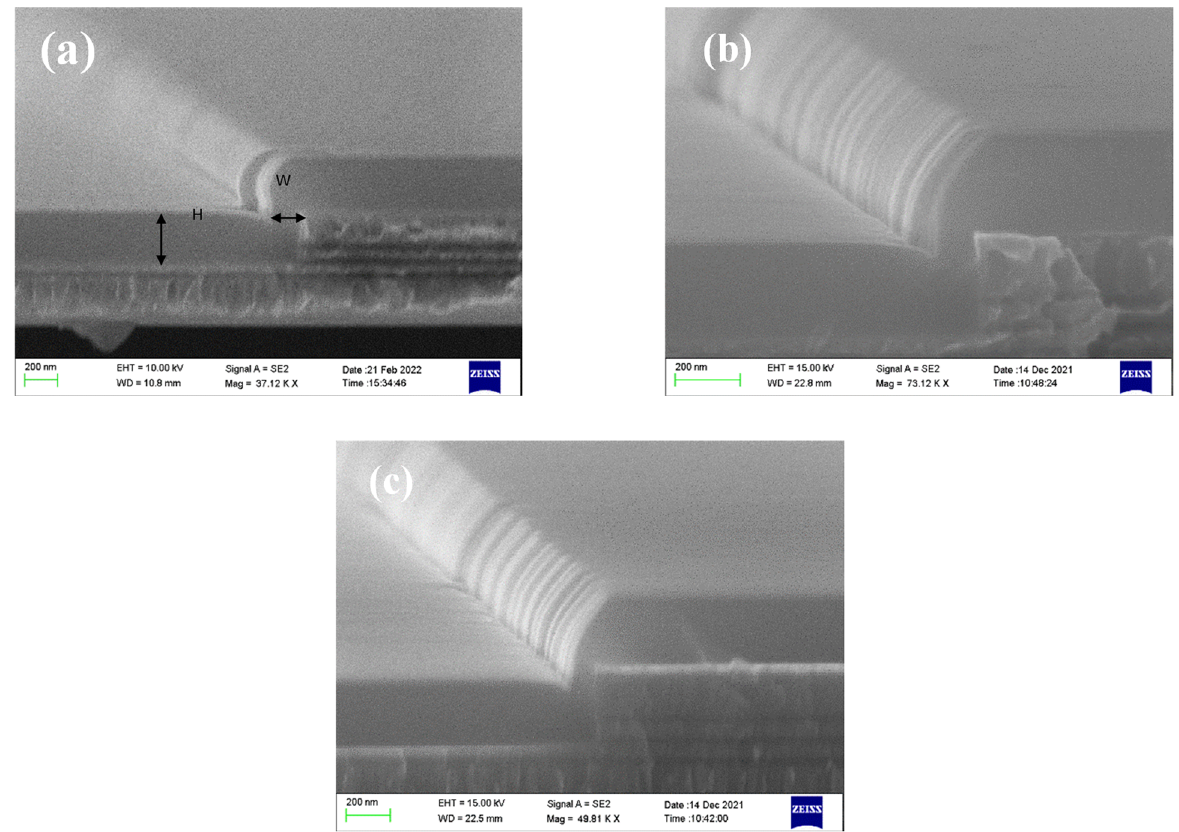
Figure 4. SEM images of the step coverage profiles for ICP powers of ( a ) 200 W, ( b ) 500 W, and ( c ) 800 W. The RF power was set at 200 W, and the deposition pressure was set at 6 mTorr.